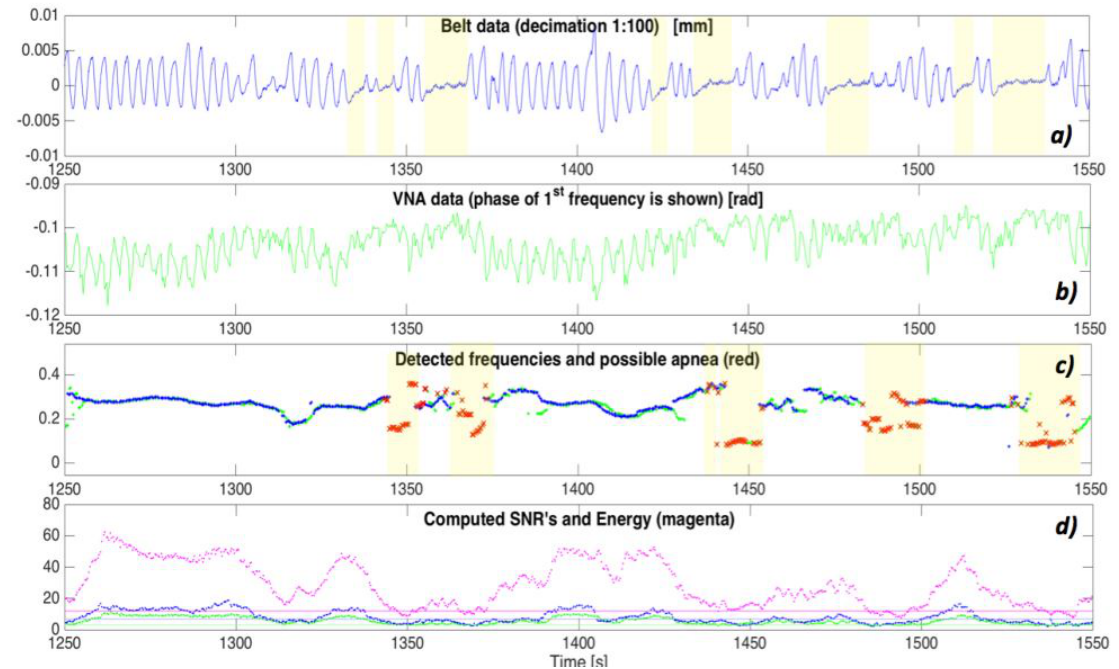
Figure 22. Exctract of a 50 min sleep monitoring: belt data ( a ); EM data ( b ); comparison of detected breathing frequencies ( c ) for 5 min of sleep (blue and green points are the frequency peaks of Fourier transforms of respectively belt and EM data); computed SNR and energy ( d